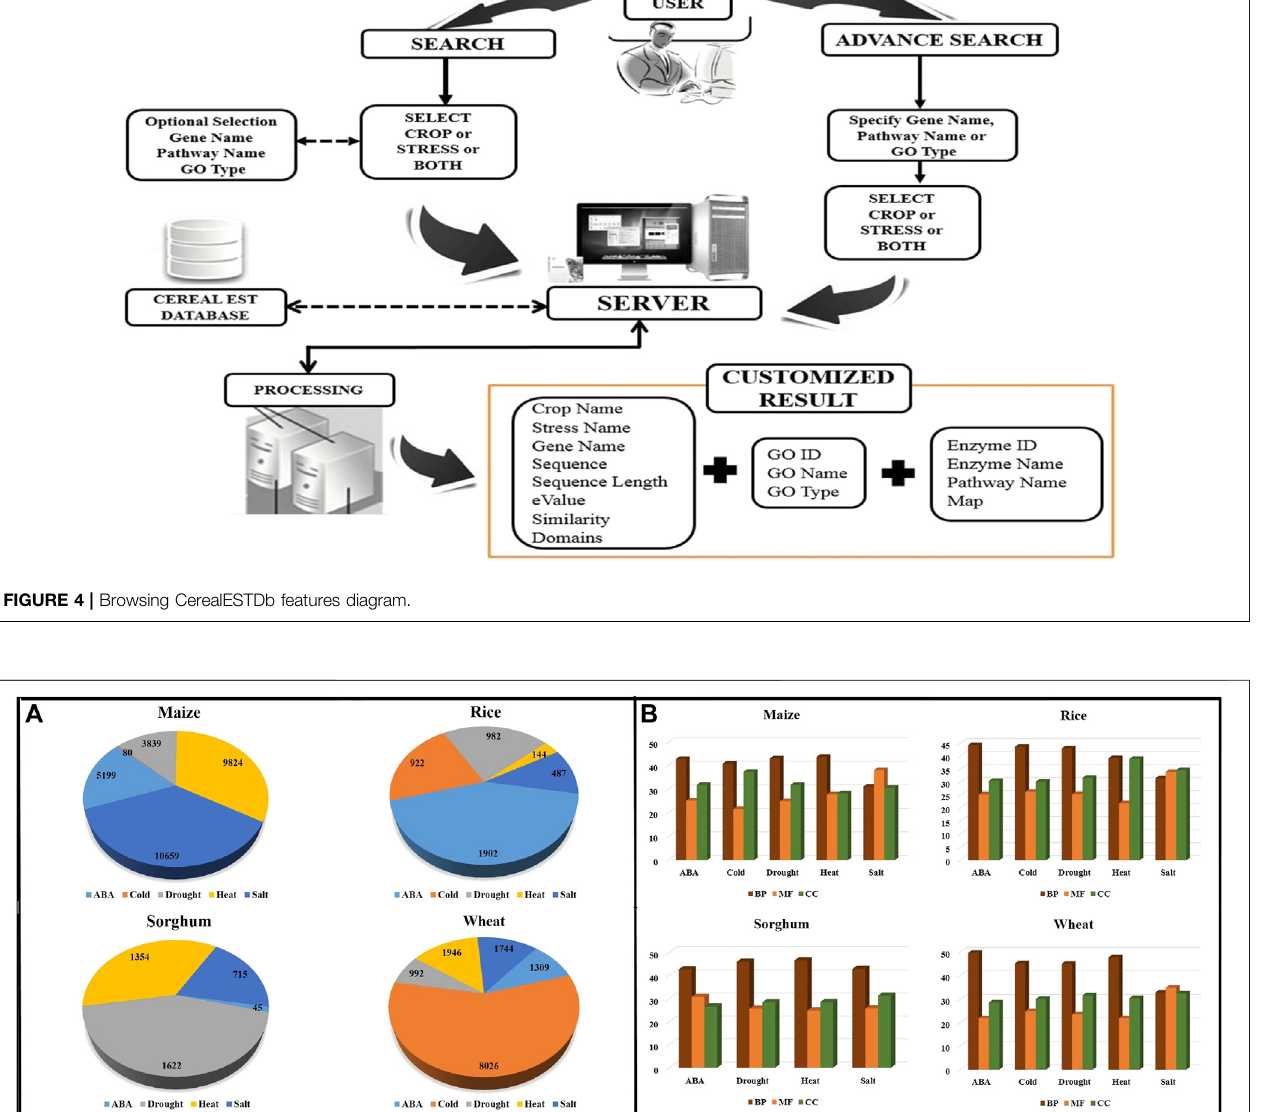
Frontiers in Genetics |